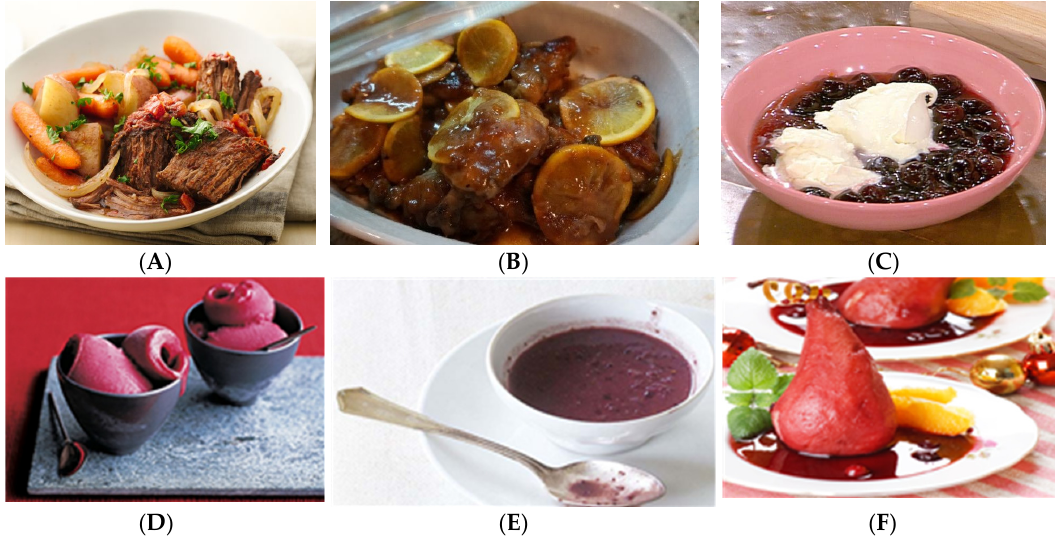
Figure 7. Pot roast Milano made with Burgundy ( A ); orange chicken Burgundy ( B ) cherry jubilee made with brandy accompanied by sour cream ( C ); a great-colored sorbet made with ripe plums and red wine ( D ); red wine pan sauce ( E ) and a wine poached pear ( F ).